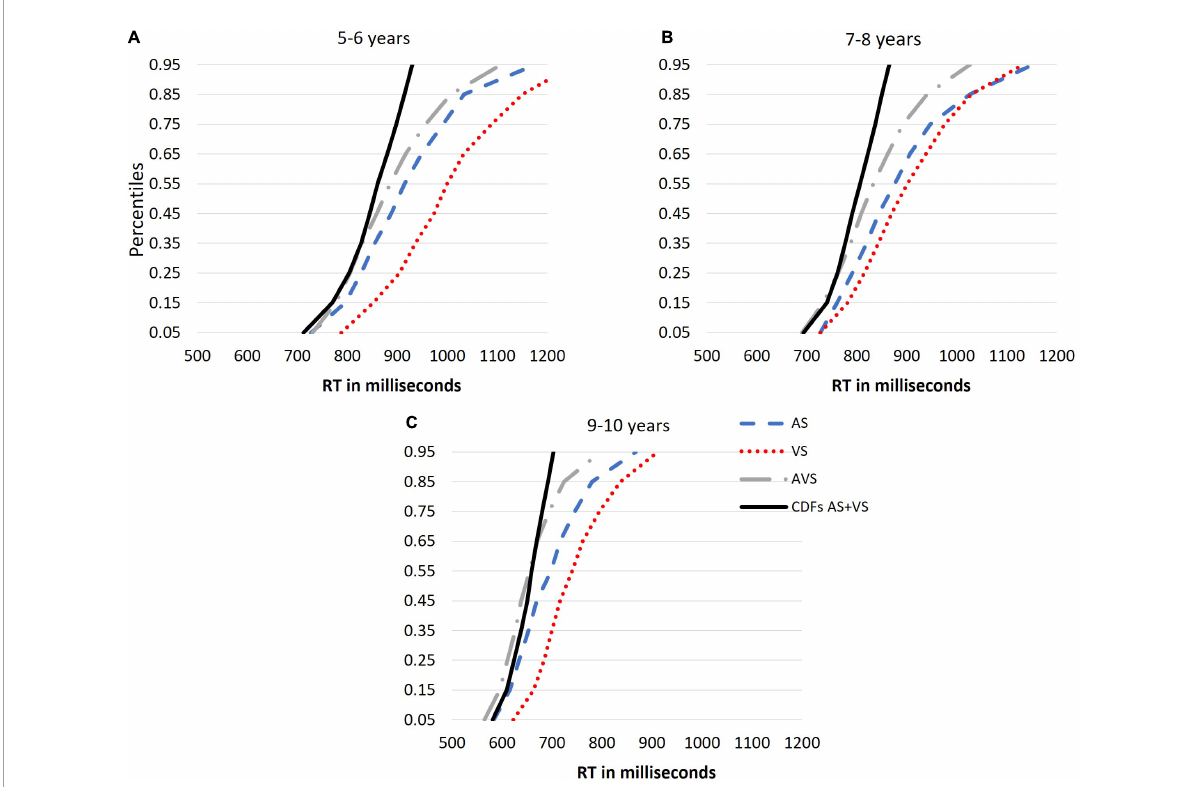
FIGURE7 (A–C) Cumulative density functions (CDFs) for each individual’s auditory stimuli (AS; blue line), visual stimuli (VS; red line), audiovisual stimuli (AVS; gray line) and the combined CDF AS+VS (the black line), CDFs were computed by calculating the probability of MRTs from 0.05 to 0.95 in intervals of 0.1 ( y -axis represent the probability).